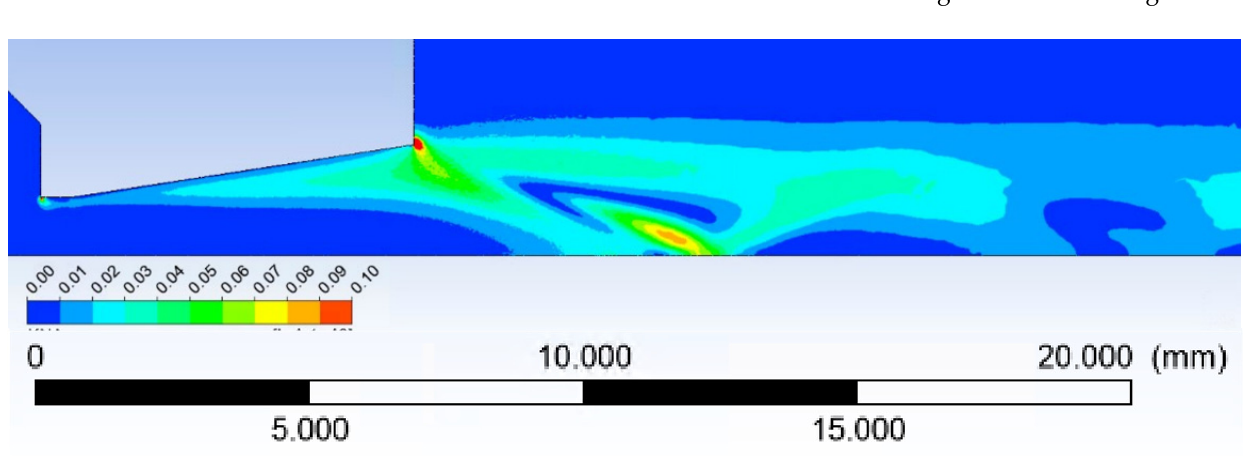
Figure 6. Knudsen number distribution [11].